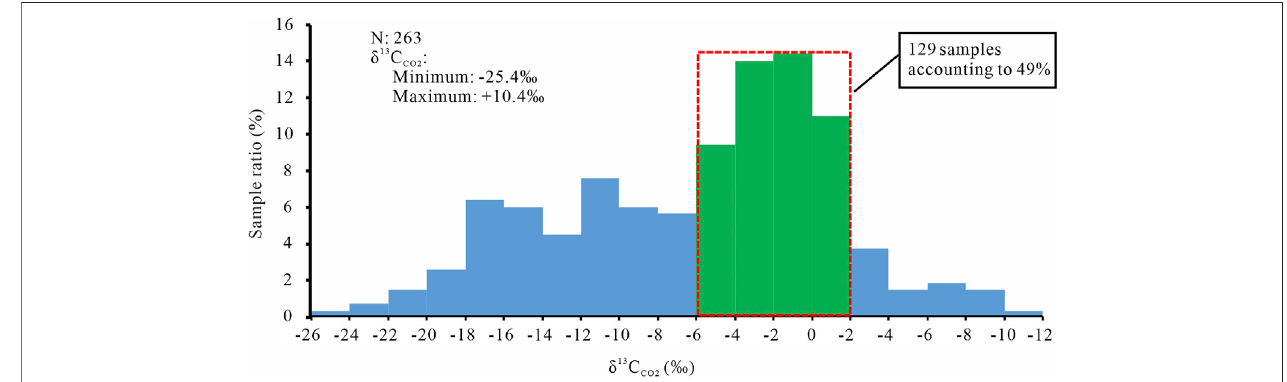
FIGURE 5 | Distribution frequency of the carbon isotopes of CO 2 in the Sichuan Basin.